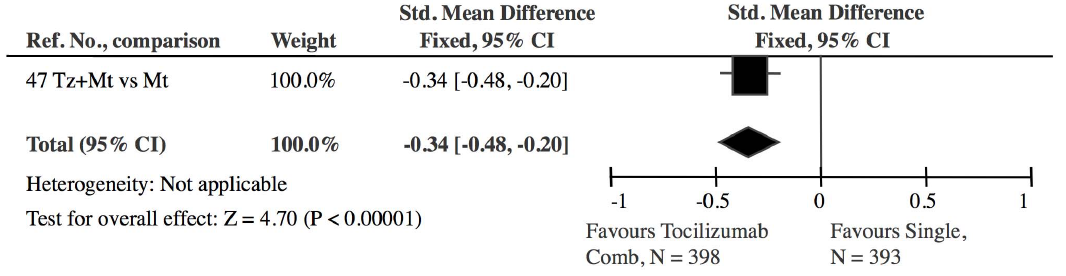
Figure 9. Tocilizumab combined with methotrexate versus single DMARD (methotrexate): The effect of tocilizumab is significant (Z=4.70).